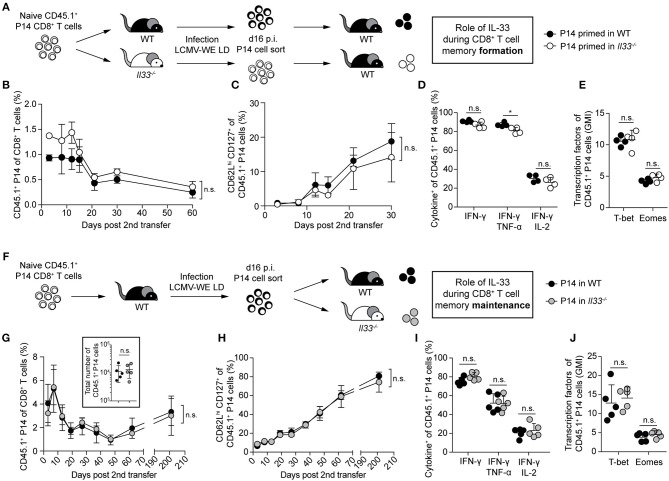
IL-33 is dispensable for CD8+ T cell memory formation and maintenance. (A) Schematic experimental layout to assess IL-33 signals during memory formation in (B–E). (B) Frequency of P14 cells in the blood of WT recipients at the indicated time points after secondary transfer. (C) Frequency of CD62Lhi CD127+ cells within the P14 cell subset. Symbols of the time course analyses represent mean ± SD (n = 4) of one representative experiment out of three performed. (D) After 65 days, recipients were sacrificed. Cytokine production of splenic P14 cells after GP33 restimulation. (E) Expression levels of T-bet and Eomes by splenic P14 cells (geometric mean index, normalized to isotype). (F) Schematic experimental layout to assess IL-33 signals during memory maintenance in (G–J). (G) Frequency of transferred P14 cells in the blood of secondary recipients and absolute numbers of P14 cells in the spleen at day 65 post second transfer (insert panel). (H) Frequency of CD62Lhi CD127+ cells within the P14 cell subset. Symbols of the time course analyses represent mean ± SD (n = 5) of one out of two experiments with similar results. (I) After 65 days, recipients were sacrificed in some experiments. Cytokine production by splenic P14 cells after GP33 peptide restimulation. (J) Expression levels of T-bet and Eomes by P14 cells (geometric mean index, normalized to isotype). Symbols represent single mice, the bars the mean + SD. P-values were calculated with unpaired two-tailed Student's t-test [starting-point-normalized Area under the curve (AUC) in (B,G), AUC in (C,H)]. *P < 0.05.